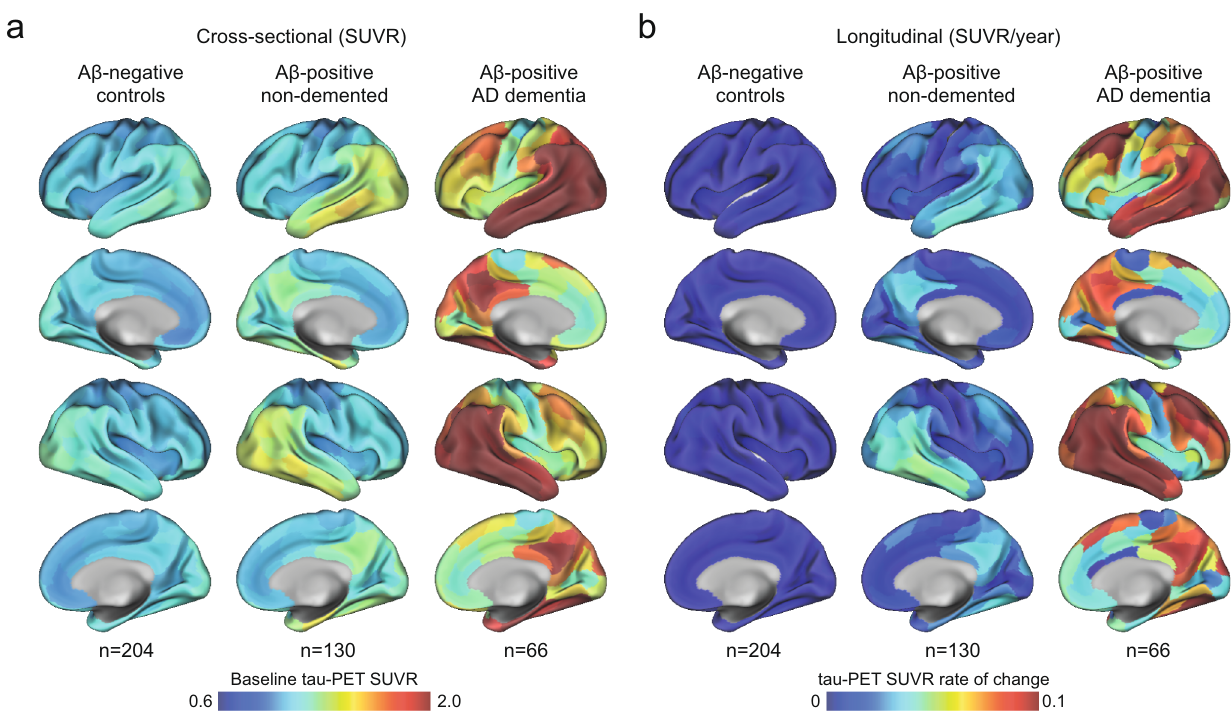
Fig. 1 | Mean spatial distribution of cross-sectional tau-PET [ 18 F]RO948 SUVR andlongitudinalrateofchange.a Surfacerenderingsofaveragebaselinetau-PET SUVR in A β -negative controls, A β -positive non-demented participants and A β - positive patients with AD dementia in the 200 parcels from the Schaefer 200-ROI atlas. b Surface renderings of yearly tau-PET SUVR rate of change derived as the slope from linear mixed-effect models in the same participants group as in a . The